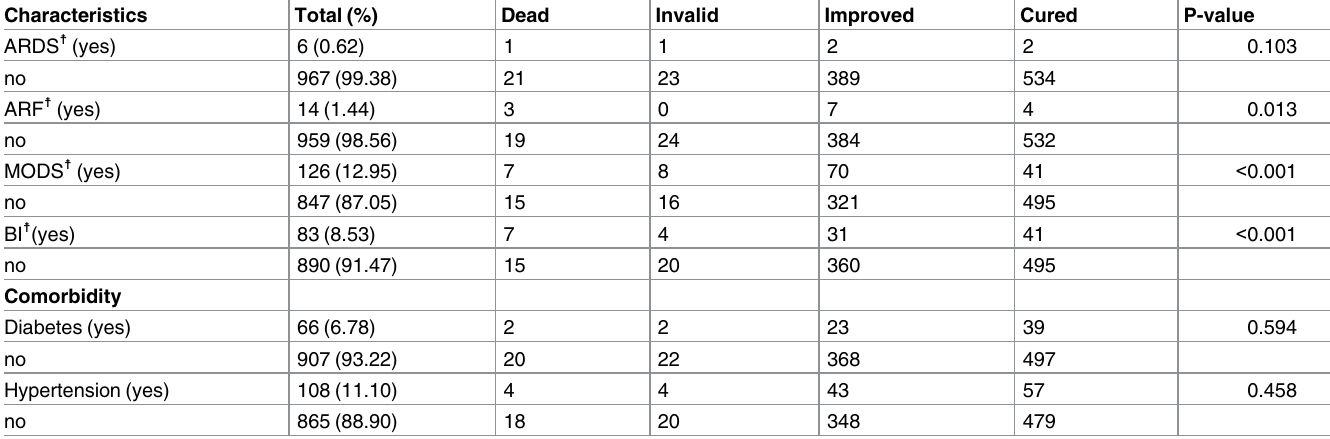
ARF and BI. If a patient was not in a coma when he/she was admitted to a hospital, the risk of mortality decreased to nearly half of that among patients in a coma (OR = 0.528). Multiple-RTI patients. Before logistic regression analysis, multicollinearity detection results indicated that the values of Tol for different variables ranged from 0.311 to 0.948 (all values > 0.1), and the values of VIF ranged from 1.034 to 3.219 (all values < 10), indicating that multicollinearity was not present. The logistic regression analysis revealed that age, admis- sion pathway, prehospital time, LOS, number of affected body regions, body region, injury outcomes (all P < 0.05) (Table